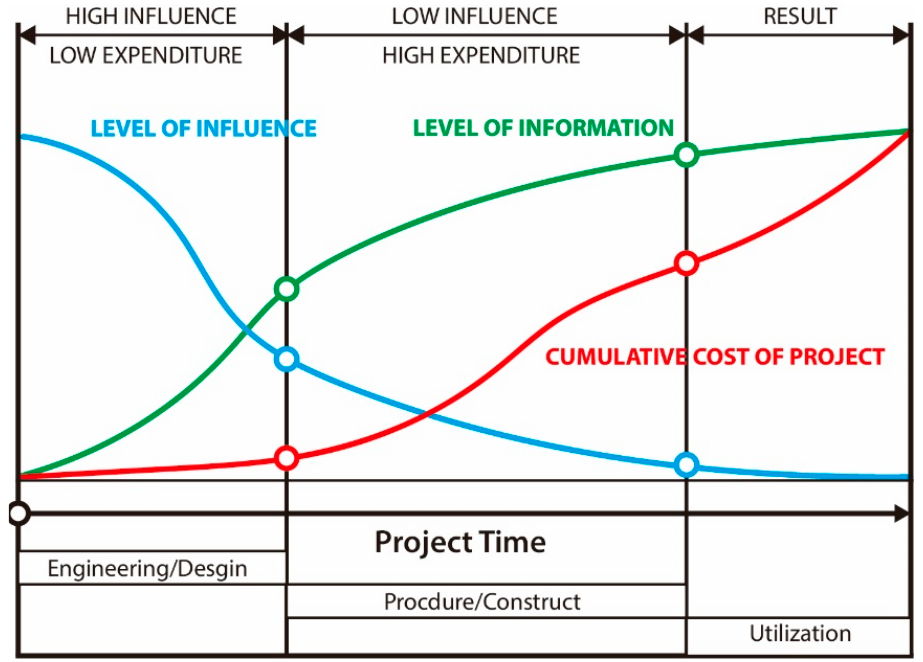
Figure 2. Level of influence and information (Paulson 1976).